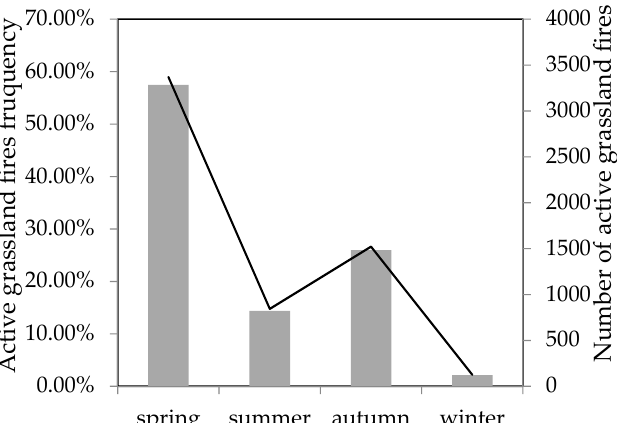
Figure 4. The seasonal distribution of active grassland fires in the study area. The line shows the number of active grassland fires; the bar shows the active grassland fires frequency.